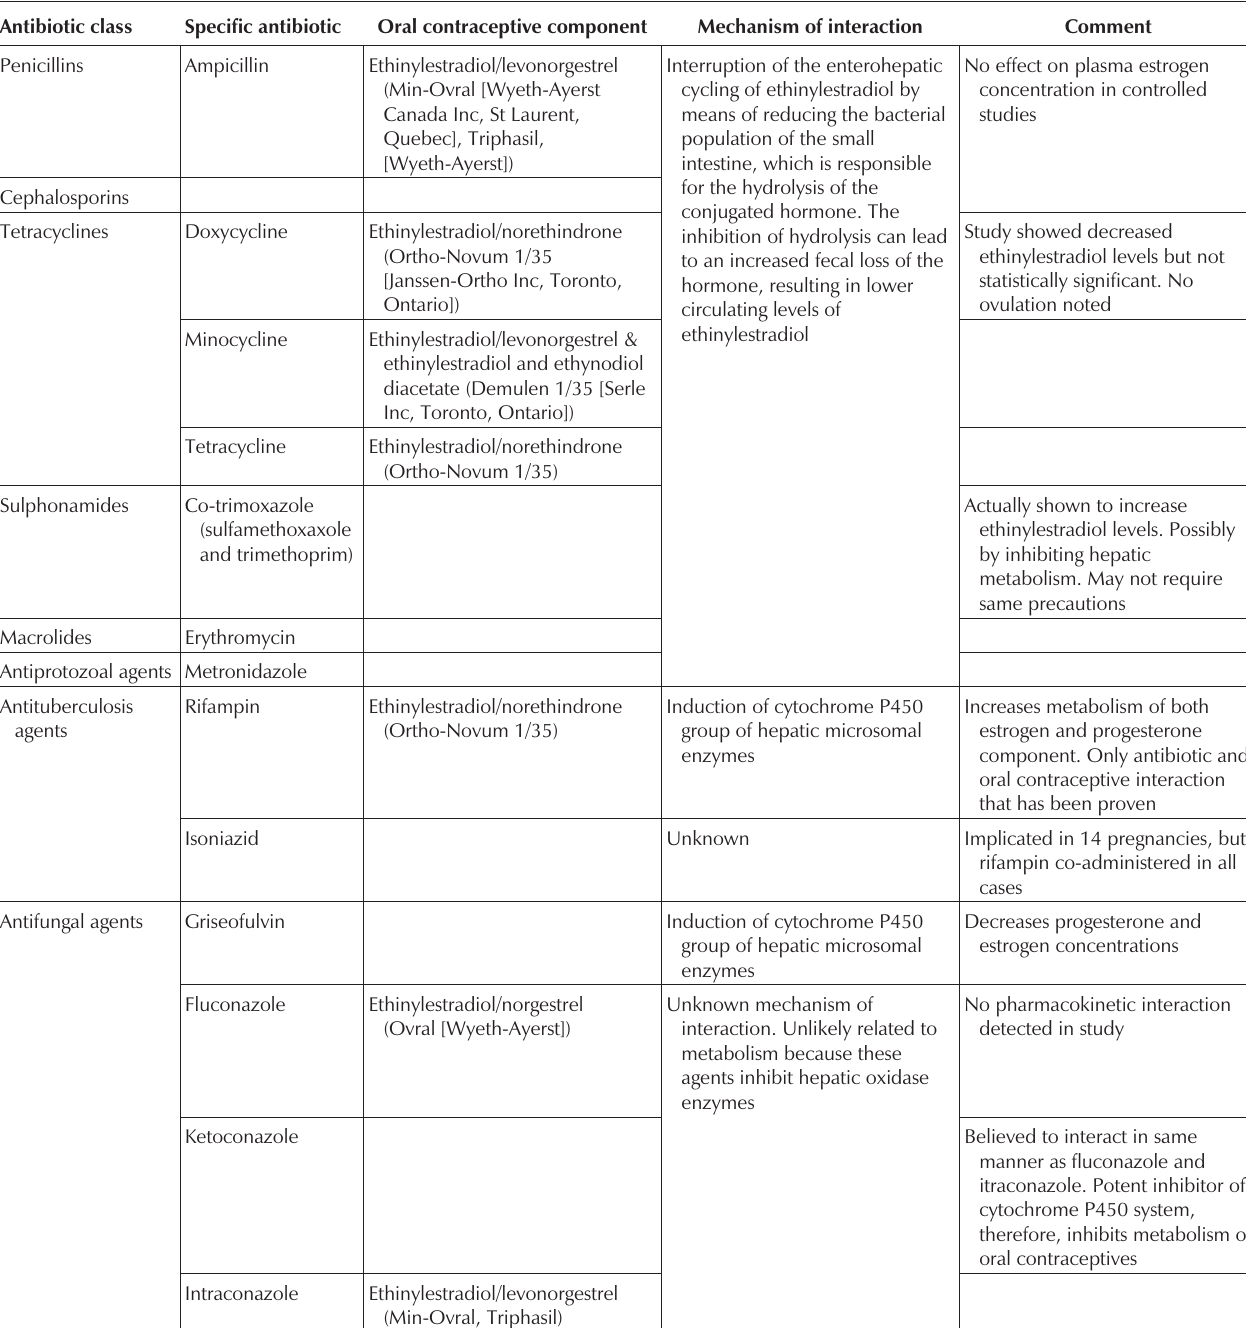
Review of reported antibiotic/oral contraceptive drug interactions Antibiotic class Specific antibiotic Oral contraceptive component Mechanism of